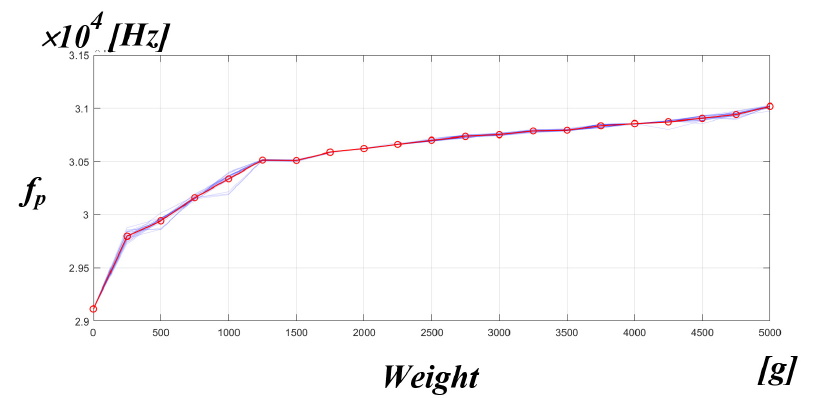
Figure 20. f piezo fluctuations due to pressure